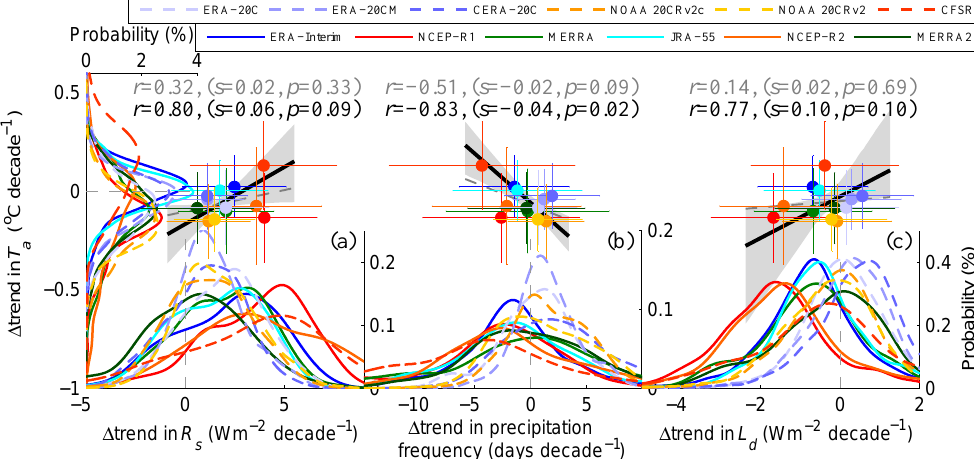
Figure 8. Spatial associations of the simulated biases in the trend in surface air temperature ( T a ) versus three relevant parameters among the 12 reanalysis products (solid lines indicate the NWP-like reanalyses, and dashed lines indicate the climate reanalyses). The probability density functions (unit: %) of these biases in the trends are estimated from approximately 700 1 ◦ × 1 ◦ grid cells that cover China. The median values (coloured dots with error bars of spatial standard deviations) of the biases in the trends in T a (unit: ◦ Cdecade − 1 ) in the 12 reanalyses are regressed onto those of (a) the surface incident solar radiation ( R s , unit: Wm − 2 decade − 1 ), (b) precipitation frequency (unit: daysdecade − 1 ) and (c) the surface downward longwave radiation ( L d , unit: Wm − 2 decade − 1 ) using the ordinary least-squares method (OLS, denoted by the dashed grey lines) and the weighted total least-squares method (WTLS, denoted by the solid black lines). The 5–95% confidence intervals of the regressed slopes obtained using WTLS are shown as shading. The regressed correlations and slopes are shown as grey and black text,